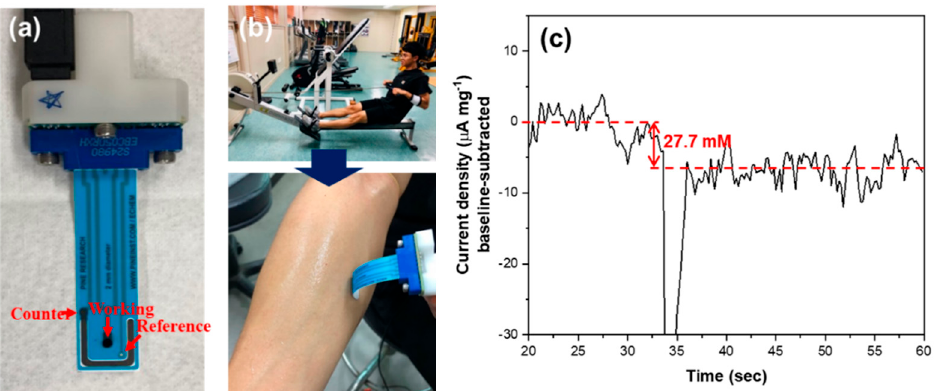
Figure 6. Demonstration of the lactic acid detection from human sweat: ( a ) The flexible printed electrode on which MWCNT-polypyrrole nanowire was deposited; ( b ) collection of human sweat from the volunteer’s forearm after exercise; and ( c ) current response from the collected human sweat. Table 1. Comparison of analytic parameters of various lactate biosensors.